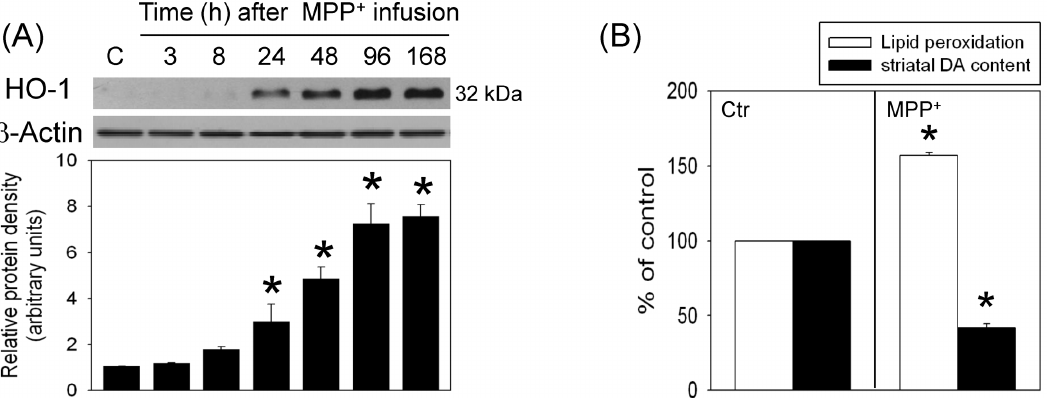
Figure 1. MPP + induced oxidative injury in the nigrostriatal dopaminergic system of rat brain. Intranigral infusion of MPP + (3 m g/ m l) was performed in the anesthetized rats. Rats were sacrificed at the indicated times. (A) Time-dependent effects of MPP + on heme oxygenase (HO)-1 level in the substantia nigra (SN) were studied using Western blot assay. Each lane contained 25 m g for all experiments. Graphs show statistical results from relative optical density of bands on the blots estimated by Image J software. Values are the mean 6 S.E.M. (n=3/group). *P , 0.05 in the MPP + -treated groups compared with the control groups by one-way analysis of variance (one-way ANOVA) and followed by the LSD test as post-hoc method. (B) Seven days after MPP + infusion, lipid peroxidation in SN was reported as relative fluorescence unit (RFU) and striatal dopamine content was detected by HPLC-ECD. Values are the mean 6 S.E.M. (n=4/group). *P , 0.05 in the MPP + -treated groups compared with the control groups by t -test.